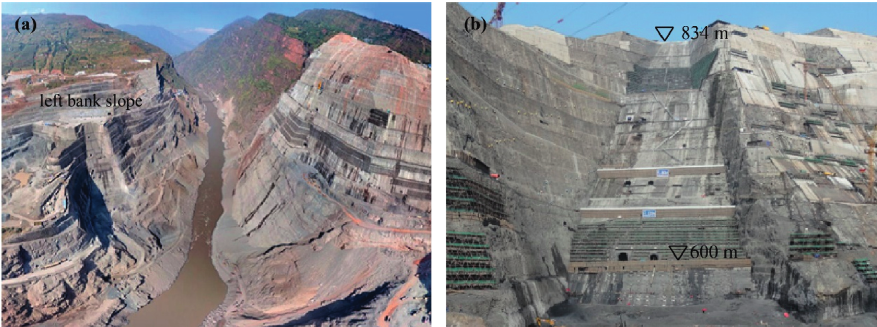
Figure 2: The pictures of slope excavation site: (a) full view of Baihetan hydropower station excavation; (b) the area of left bank slope spandrel